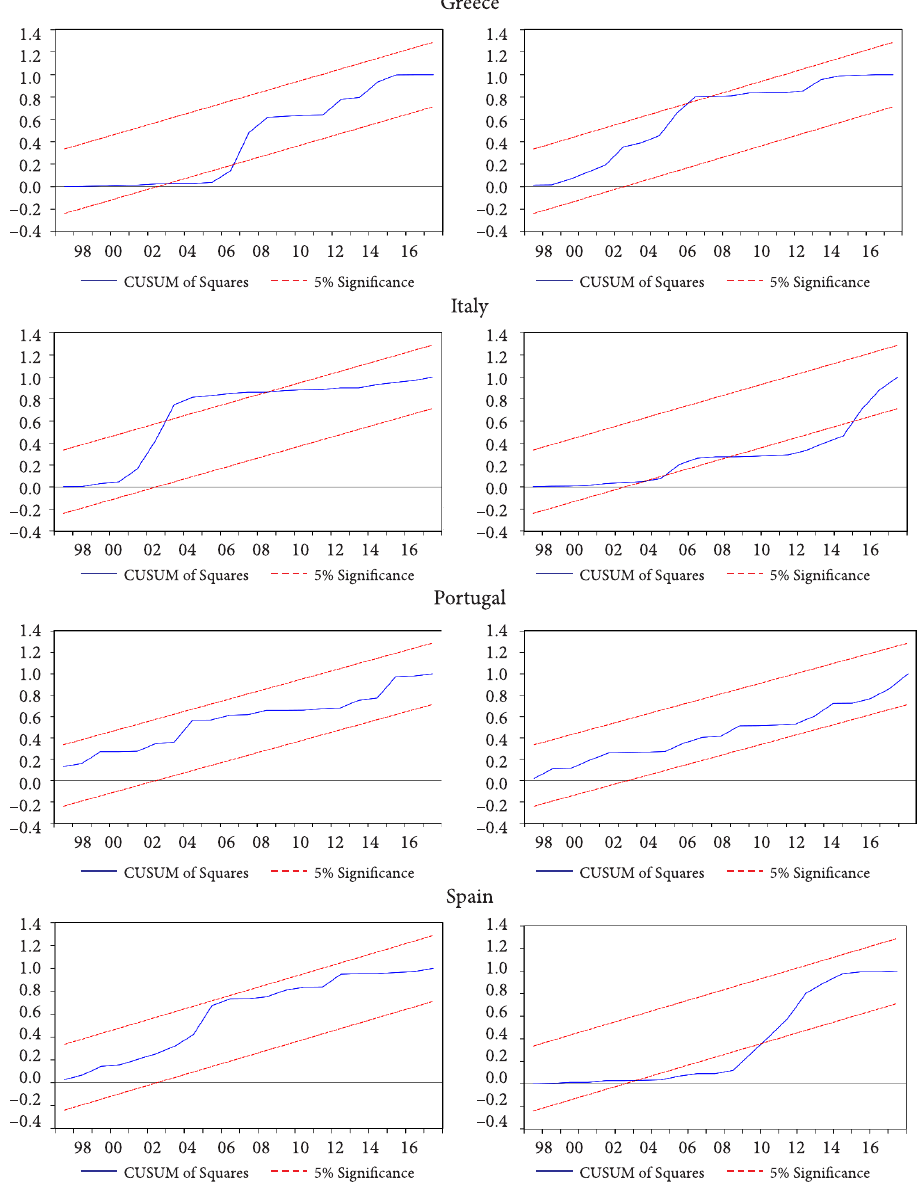
Figure 1. Testing the presence of breaks in ln_GVA (left) and UR